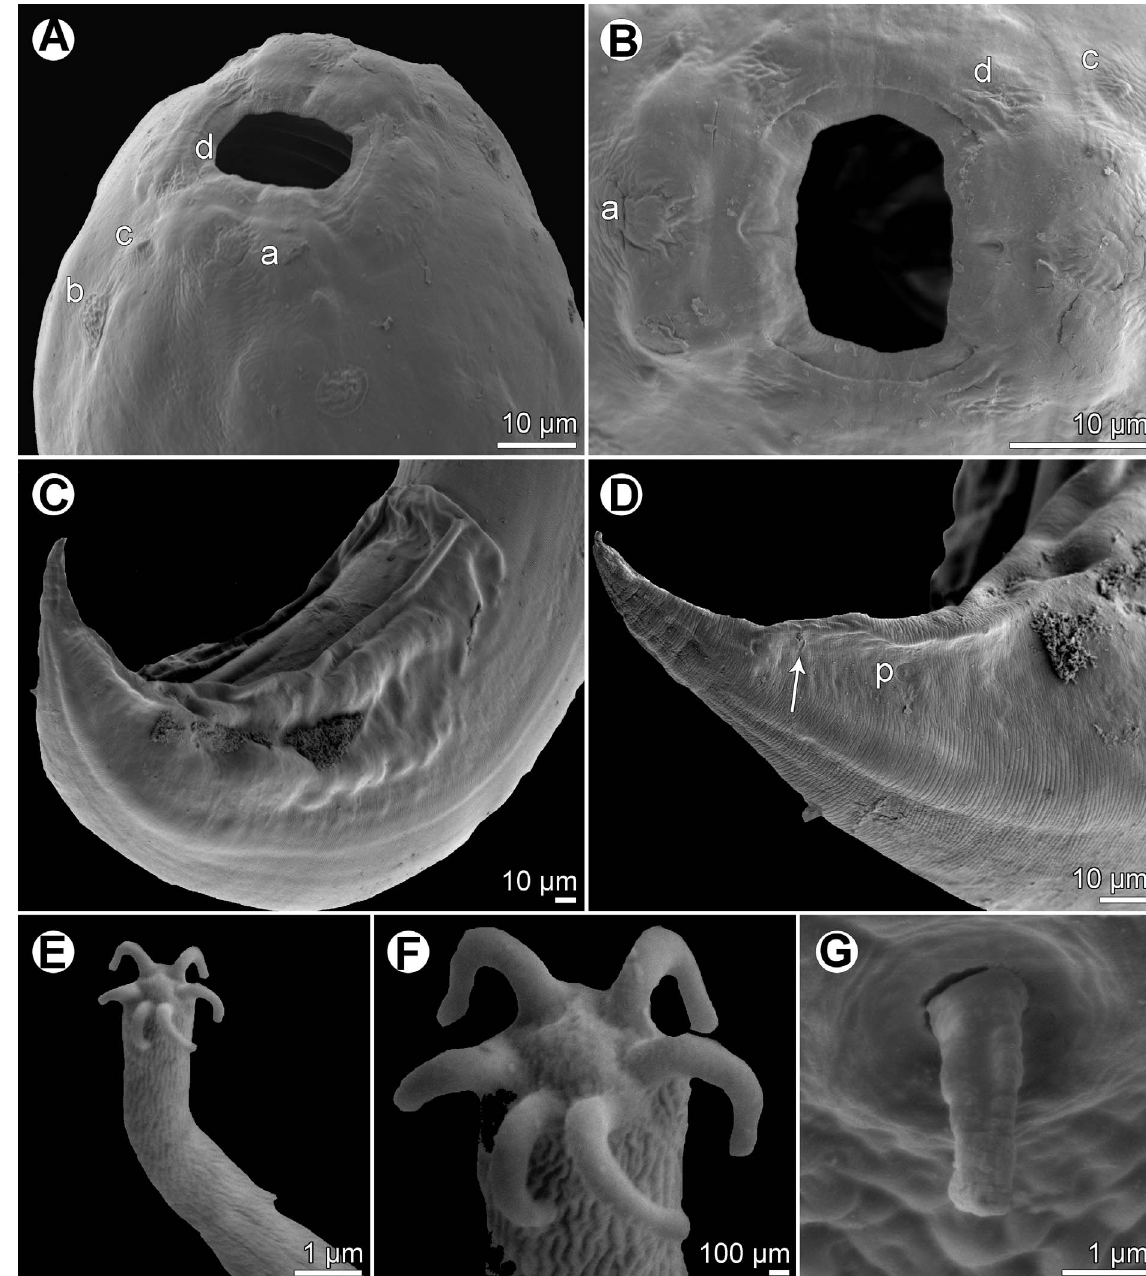
Figure 6. Procamallanus ( Spirocamallanus ) hexophtalmatis n. sp., scanning electron micrographs. (A, B) Cephalic end of female, sublateral and apical views, respectively; (C) posterior end of male, sublateral view; (D) posterior portion of male tail, lateral view (arrow indicates postanal papilla); (E) distal end of tail of fi rst-stage larva; (F) digital appendages on tail tip of fi rst-stage larva; (G) deirid. (a)